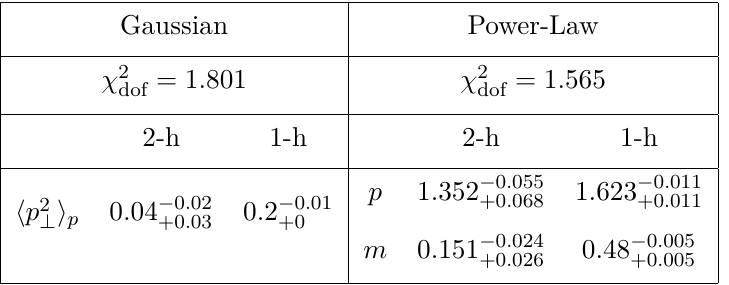
Table 4 . Values of the best fit parameters for the nonperturbative function, M ⊥ independent sets of parameters for the 2-h and 1-h data sets, for the Gaussian and Power-Law models.